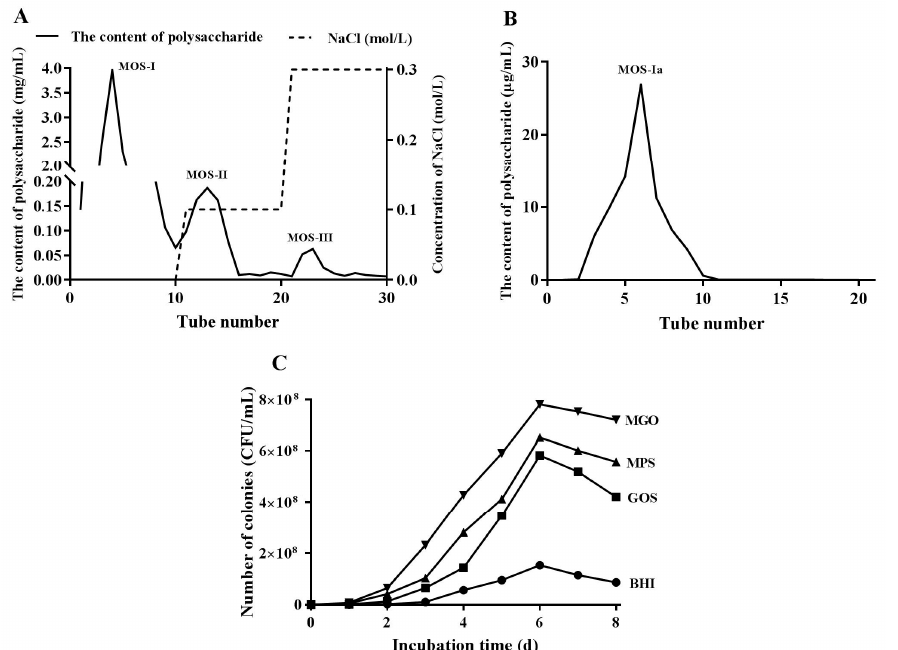
Figure 1. Elution profile of MOS produced via digestion of MPS 5% β -mannanase from a DEAE-52 cellulose column ( A ). Elution of fraction MOS-I from a Sephadex G-100 chromatography column ( B ). Curve of Akkermansia muciniphila growth in BHI medium supplemented with different prebiotics ( C ). Table 3. Proliferation of A. muciniphila cultured in medium containing different elution fractions